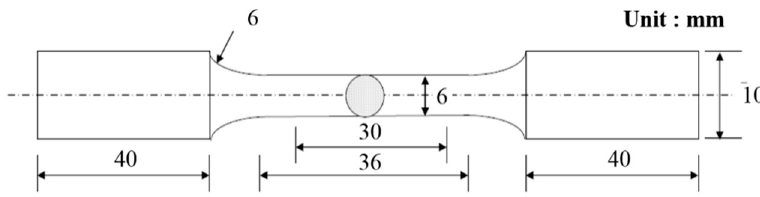
Figure 2. ASTM E8M standard specimen architectonic used for tensile test.